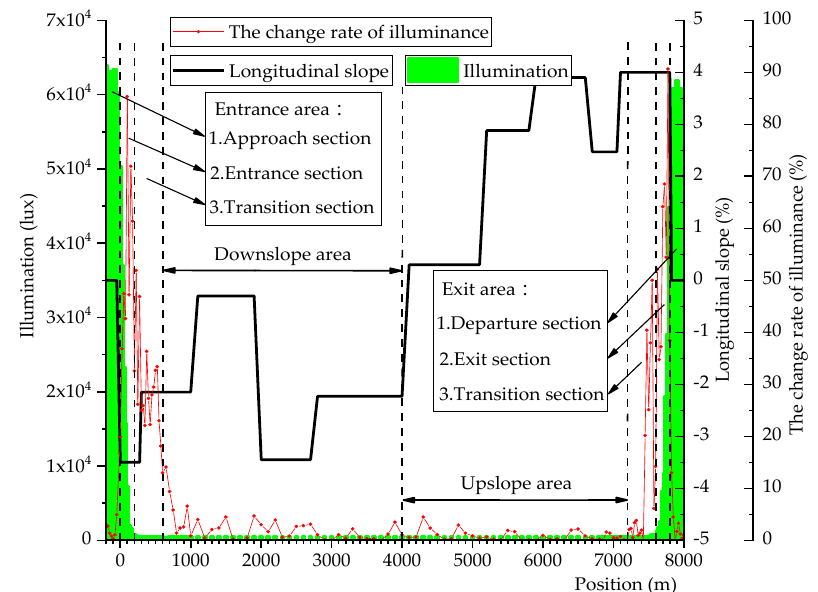
Figure 2. The distribution of illuminance and longitudinal slope of the undersea tunnel.